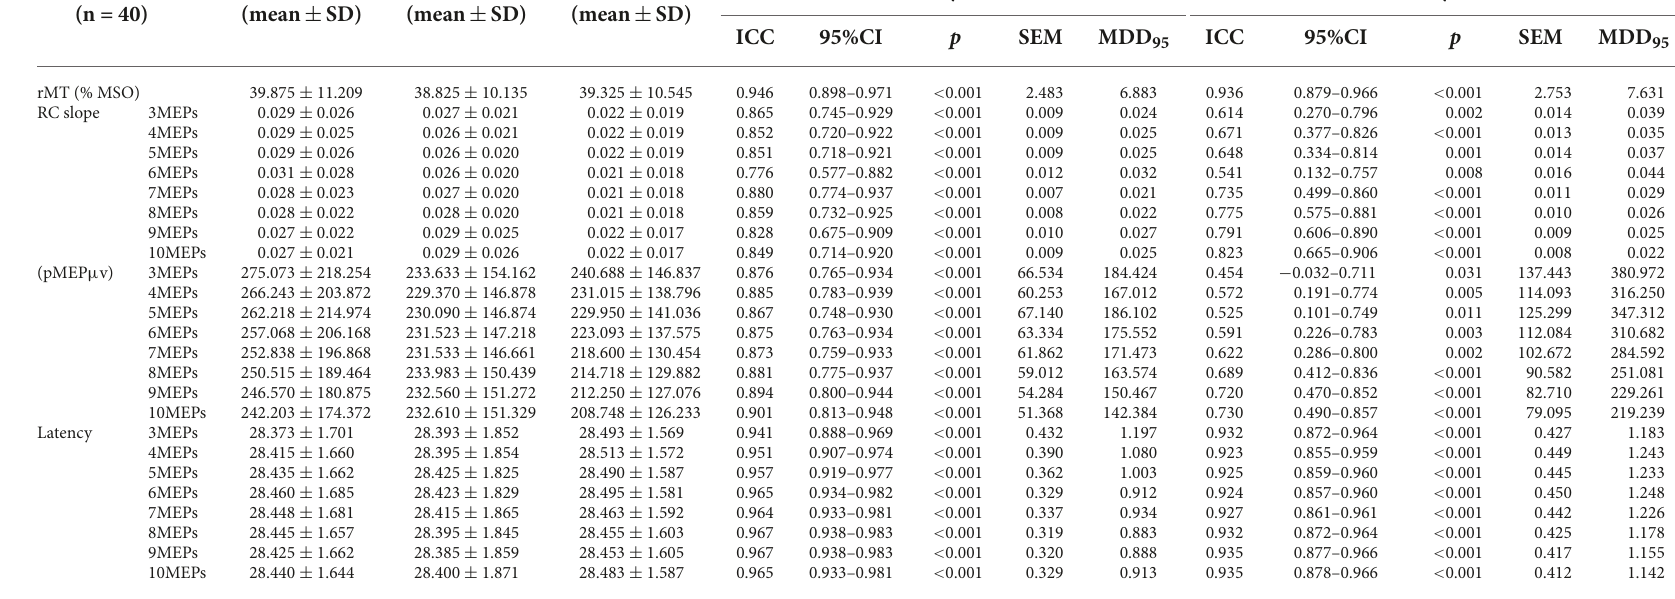
TABLE 2 Within-day and between-day reliability measures for the